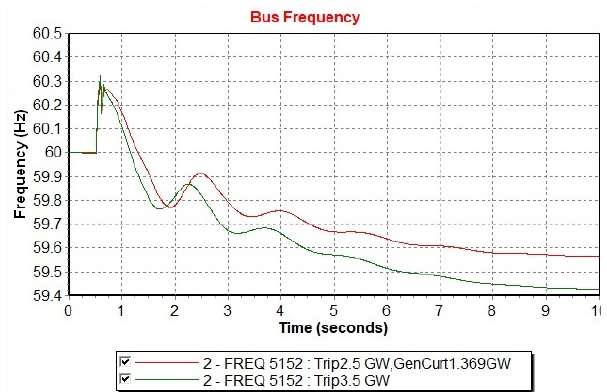
Figure 7. System frequency curves with the 3.5 and 2.5 GW generation tripping (60% load